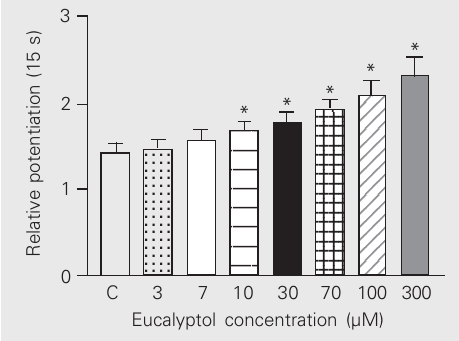
Figure 3. Effect of increasing concentrations of eucalyptol on the relative potentiation ob- tained after pauses of 15 s dura- tion. Results are reported as means ± SEM for N = 8. *P < 0.05 for eucalyptol vs control (C, one-way